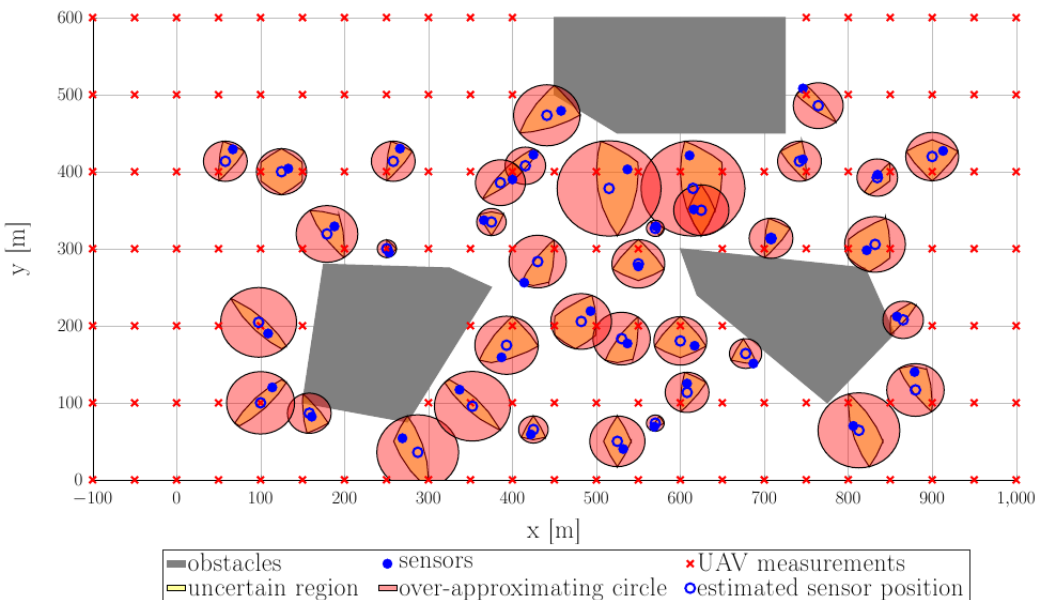
Figure 9. Estimation of the sensor location in both exact and over-approximated (by circles).